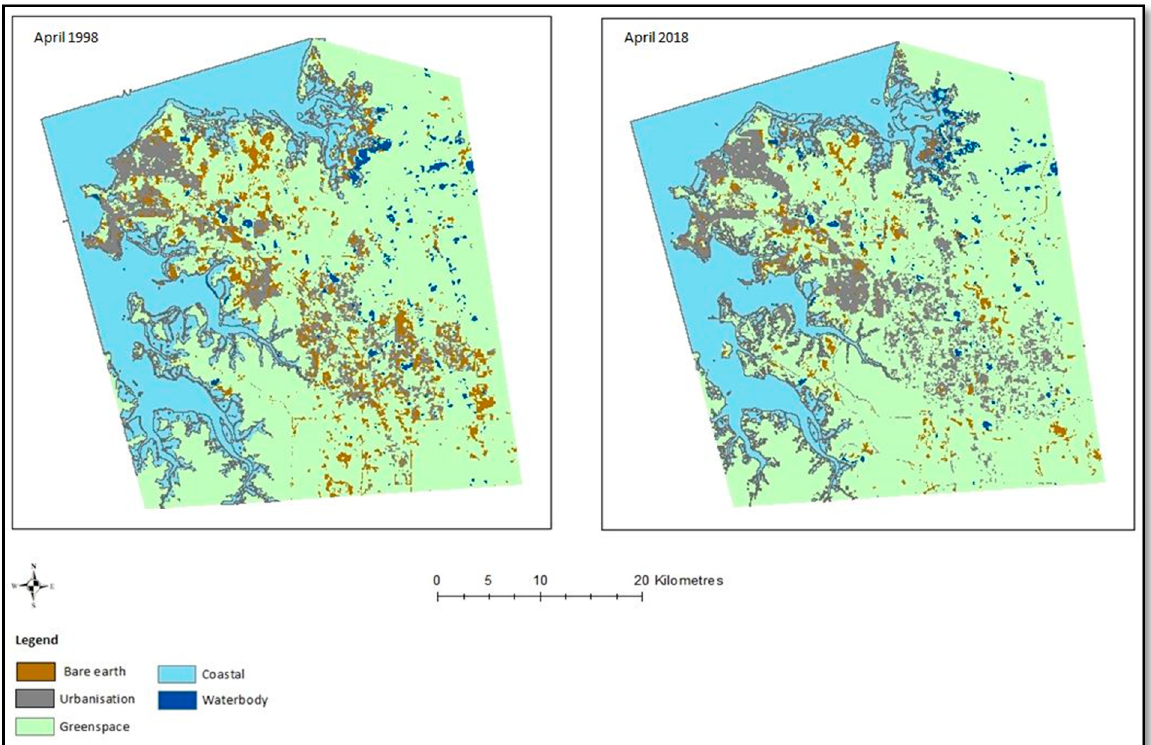
Figure 2. Final classified images of land use change with combined land classes .